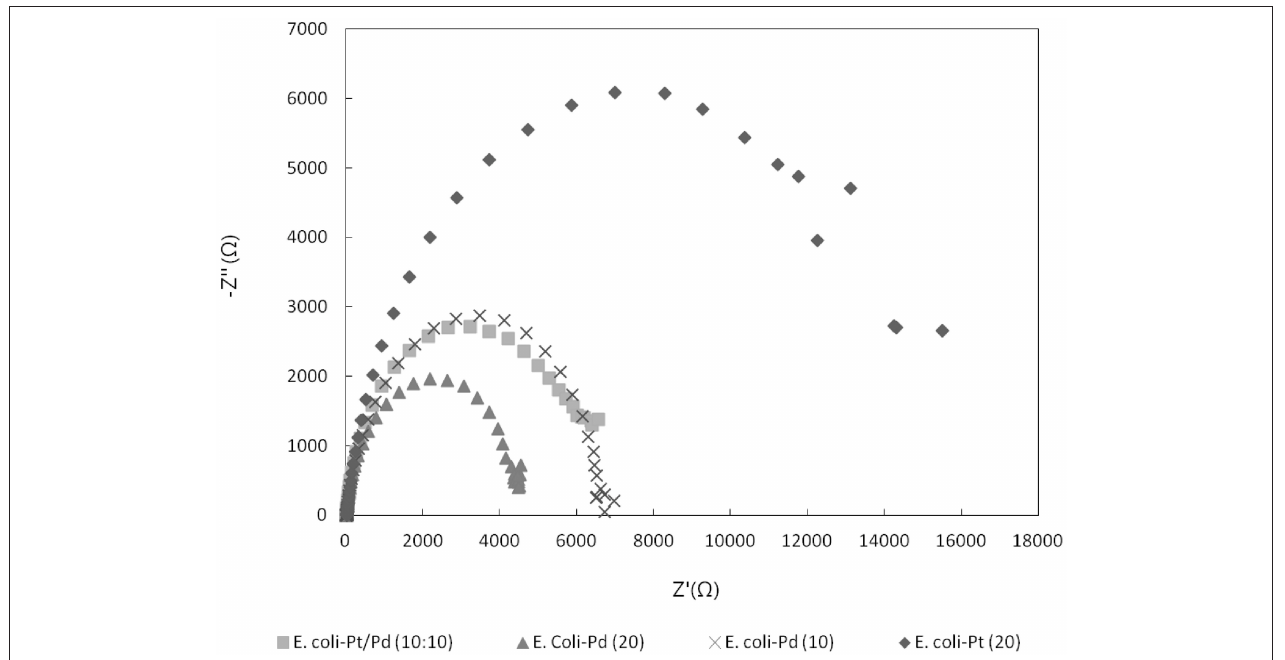
FIGURE 8 | Nyquist plot comparing E.coli -Pt/Pd impedances against E. coli -Pd (20%), E. coli- Pd (10%), and E. coli -Pt (20%).